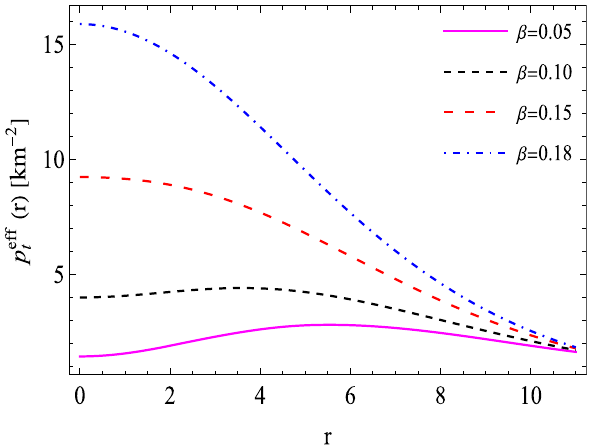
Fig. 4 The above figure show the behavior of the effective tangential pressure ( p eff